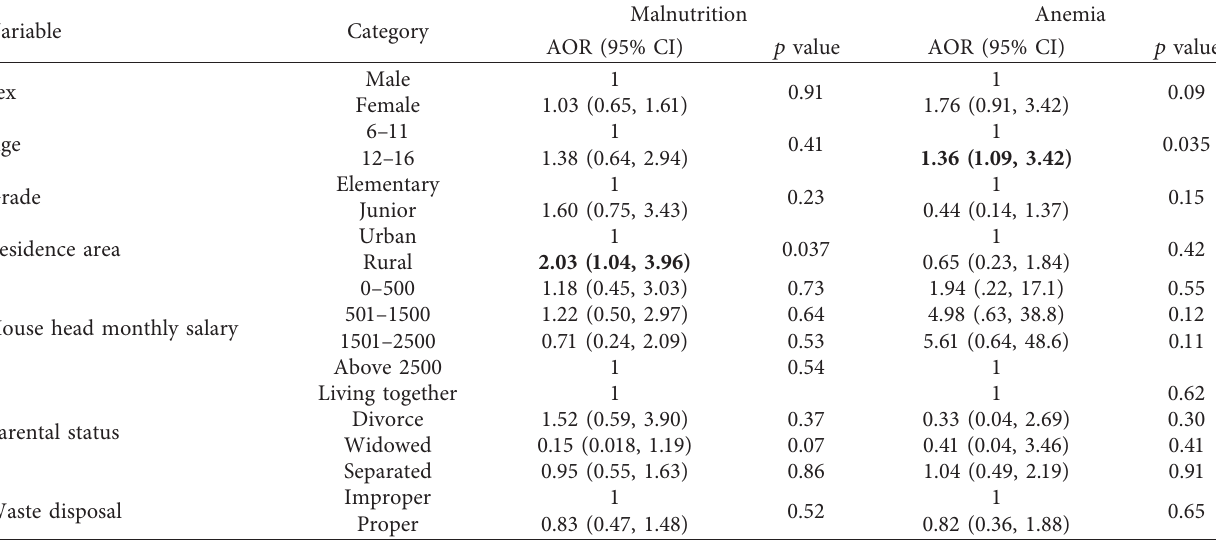
Table 5: Multivariate logistic regression analysis showing predictors of malnutrition and anemia among school children, n � 450.